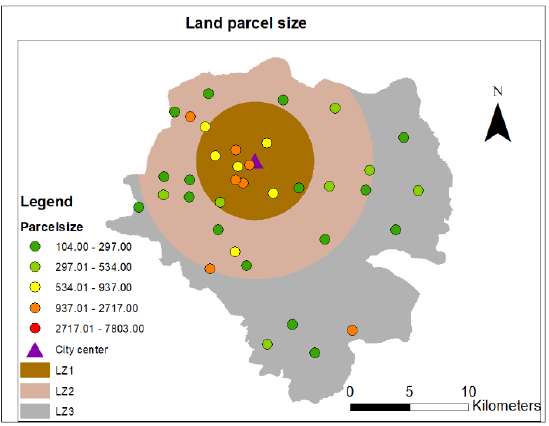
Figure 11. Urban land size (in square meters) distribution for land leasing.